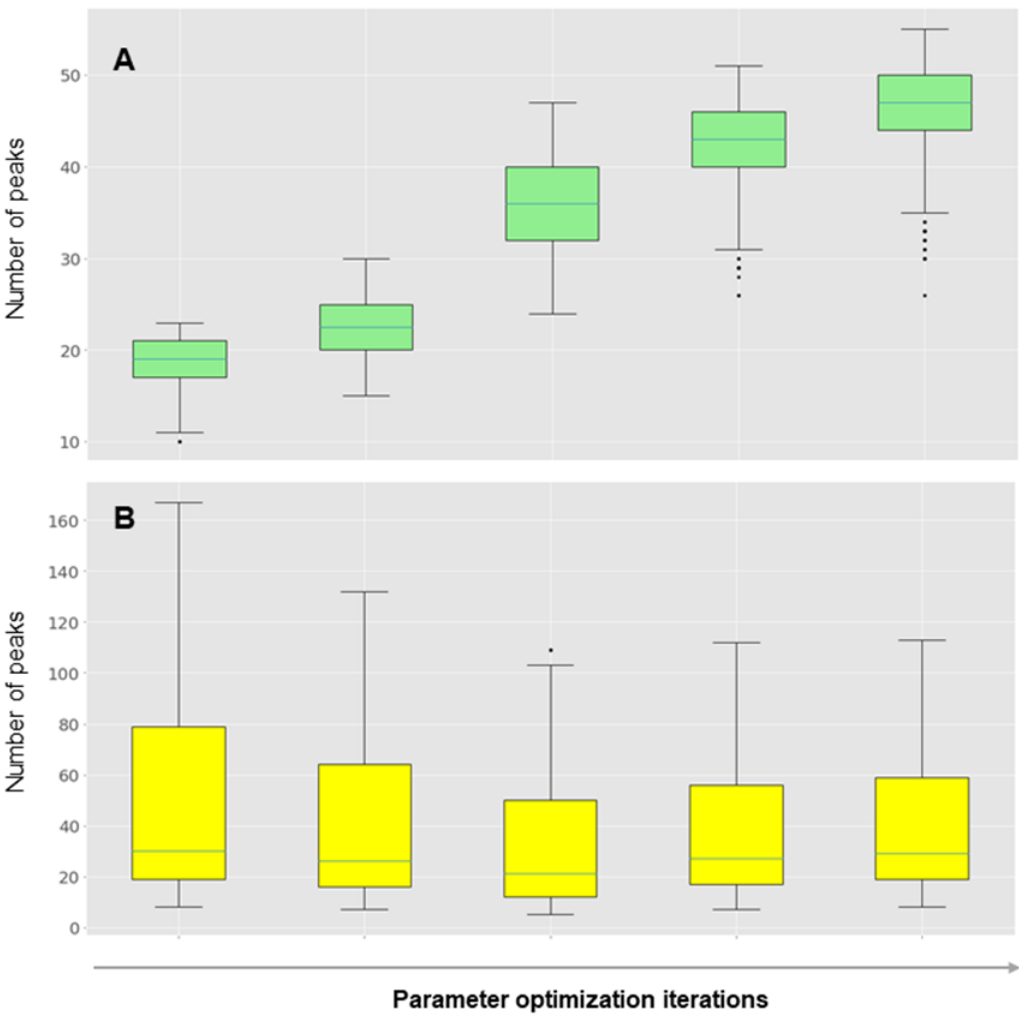
Figure 3. Bioinformatic pipeline optimization of well-defined peak detection for ovarian cancer classification. ( A ) CHCA-matrix-generated data optimization. ( B ) SA-matrix-generated data optimization. Optimization was conducted by systematic combination of two peak-detection parameters, the percentage of tolerance of well-defined peak (TWP), and minimum distance between peaks for peak finding (MD). The ranges for scanning for TWP were set from 95% to 85%. For the MD, the scanning ranges were set from 20 m/z to 50 m/z for CHCA data and from 300 m/z to 500 m/z for SA data. Parameters were systematically combined with an algorithm to either fetch gains on maximum peaks detected or reduce variations between samples.